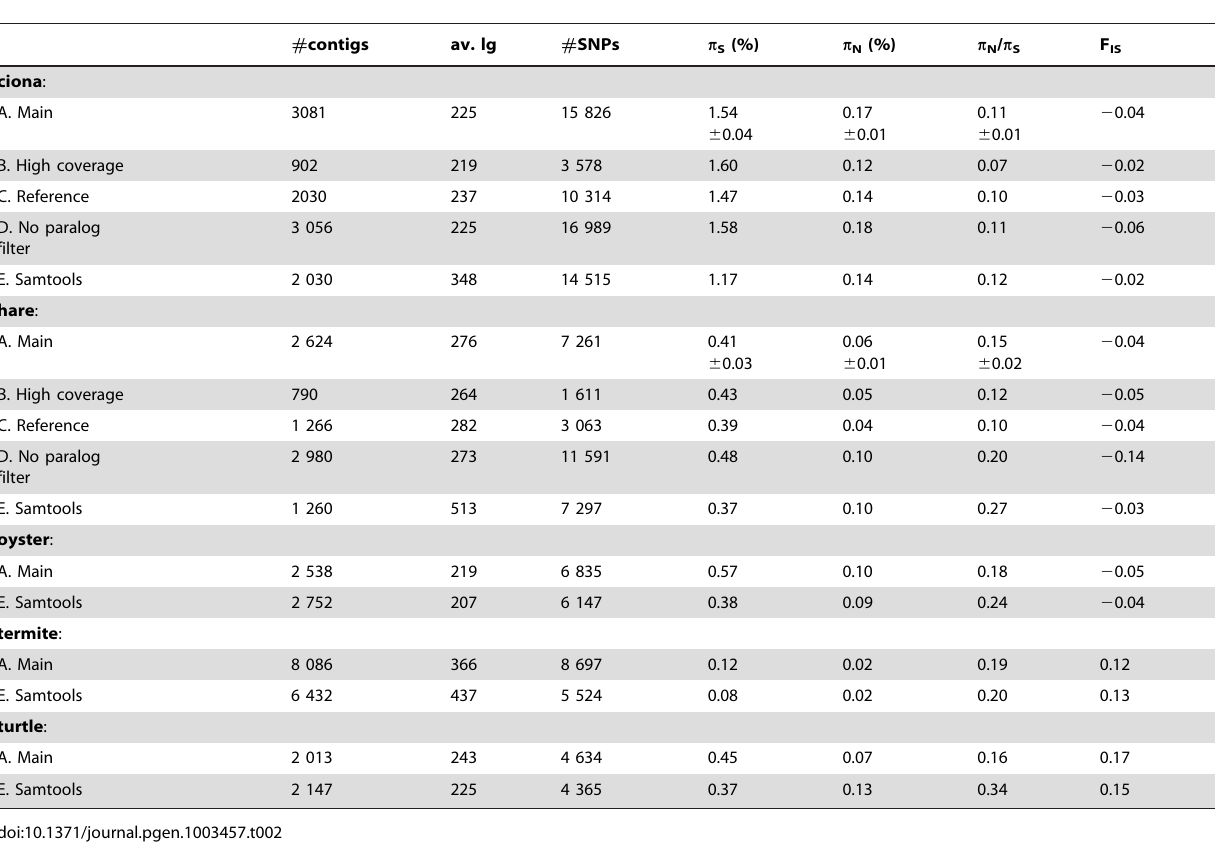
Table 2. Robustness of population genomic statistics to SNP calling options.